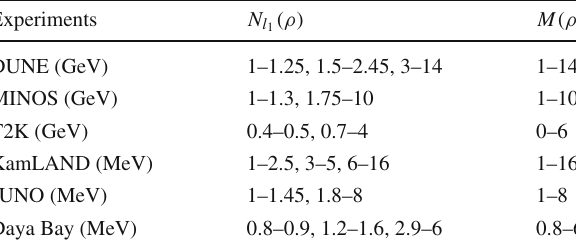
Table2 Energyregionsshowingtheviolationof M ρ andNAQCforsix different experimental set-ups. For accelerator experiments the energy range liesinGeV region, while for reactorexperiments they are inMeV.